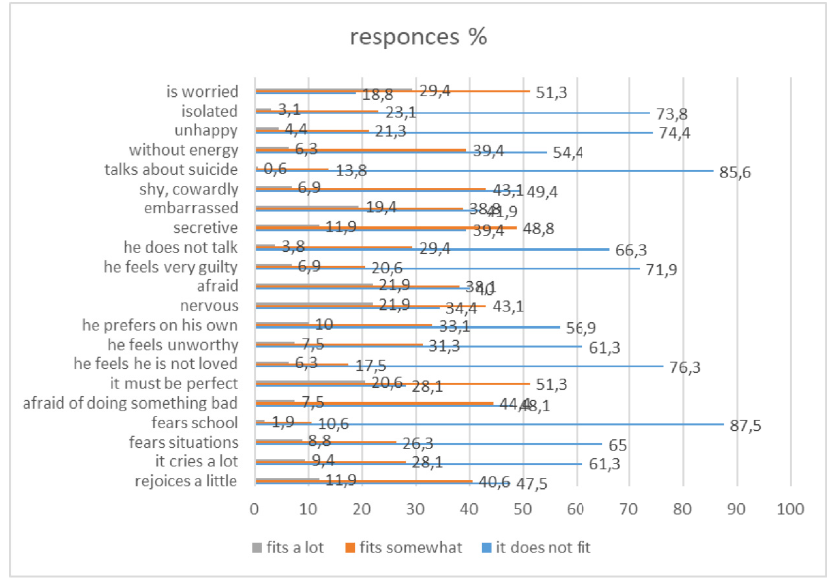
Fig. 1. Response rates in the self-report questionnaire for children and